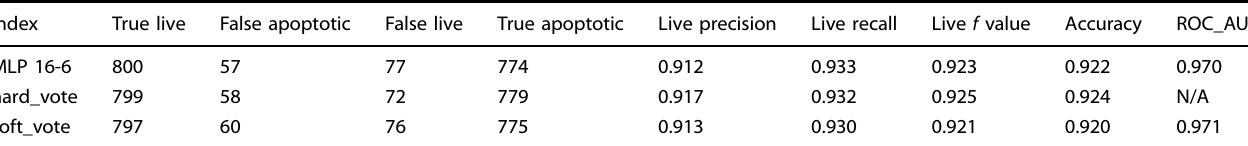
Fig. 3 Comparison of predictive performances of the three candidate models. a ROC curves of the candidate models. b Precision-recall curves of the candidate models. Both ROC and Precision-recall analysis indicated that the three multilayer perceptron-based models yielded comparable performance when predicting live cells. Table 2. Predictive performances of the ensemble models based on the three candidate models using two labels (0: live, 1: